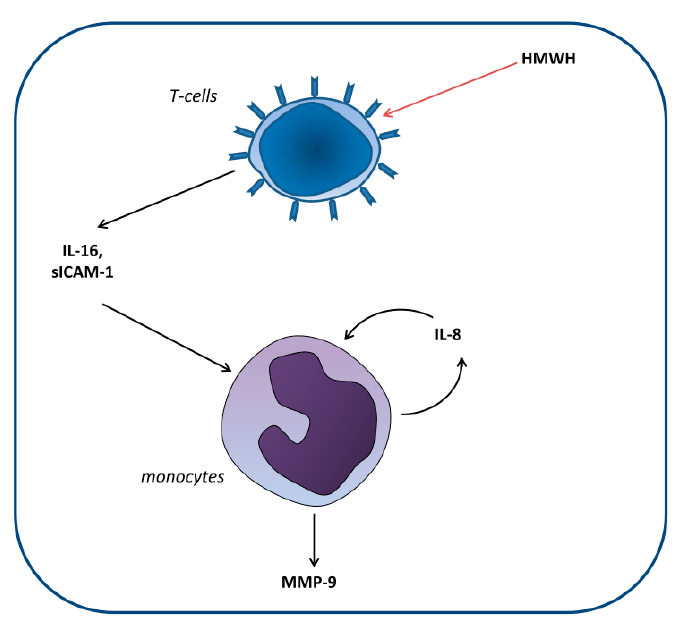
Figure 8. Proposed model of MMP-9 induction in monocytes by HMWH-treated T cells. Our data suggest that in response to HMWH, T cells secrete the mediators IL-16 and sICAM-1, which induce monocytic IL-8 production. Together, these factors yield a continuing IL-8 secretion as well as an enhanced MMP-9 production by monocytes.